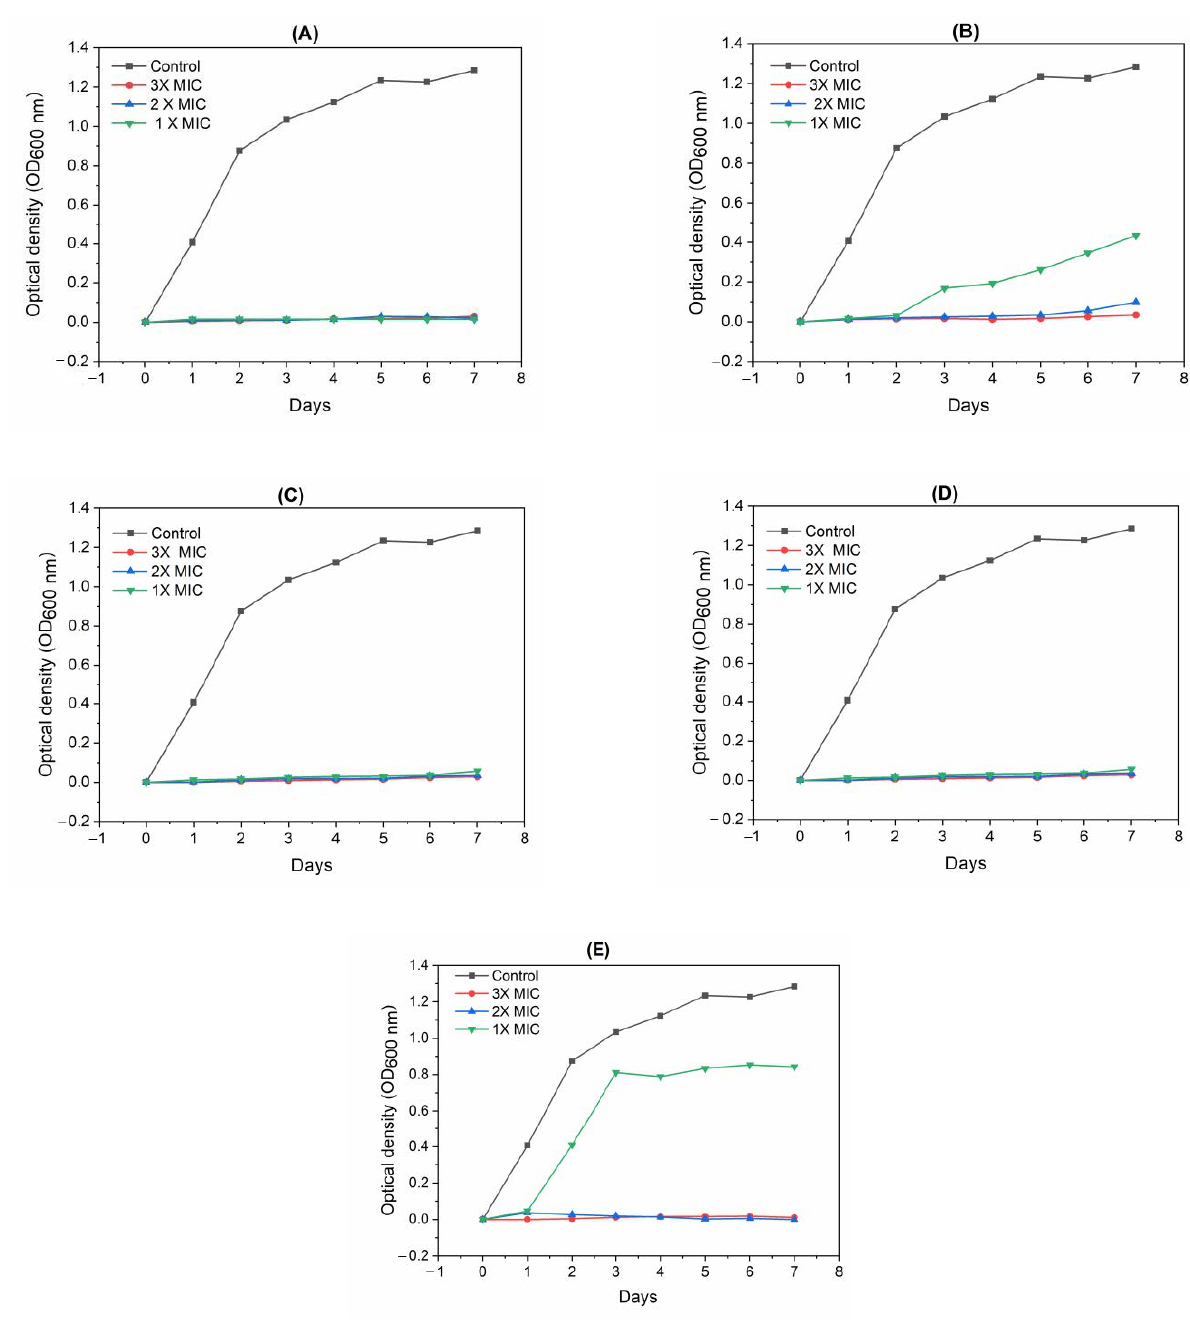
Figure 3. Development of resistance by S. aureus in the presence of the tested fluoroarylbichalcophenes at (3, 2, and 1 × MIC) during 7 days of incubation. ( A ) MA-1156 compound; ( B ) MA-1115 compound; ( C ) MA-1116 ; ( D ) MA-1113 ; ( E ) MA-1114 .